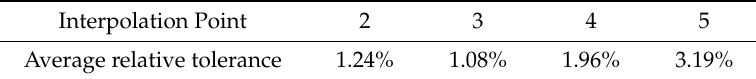
Table 5. Average relative tolerance under different interpolation points.